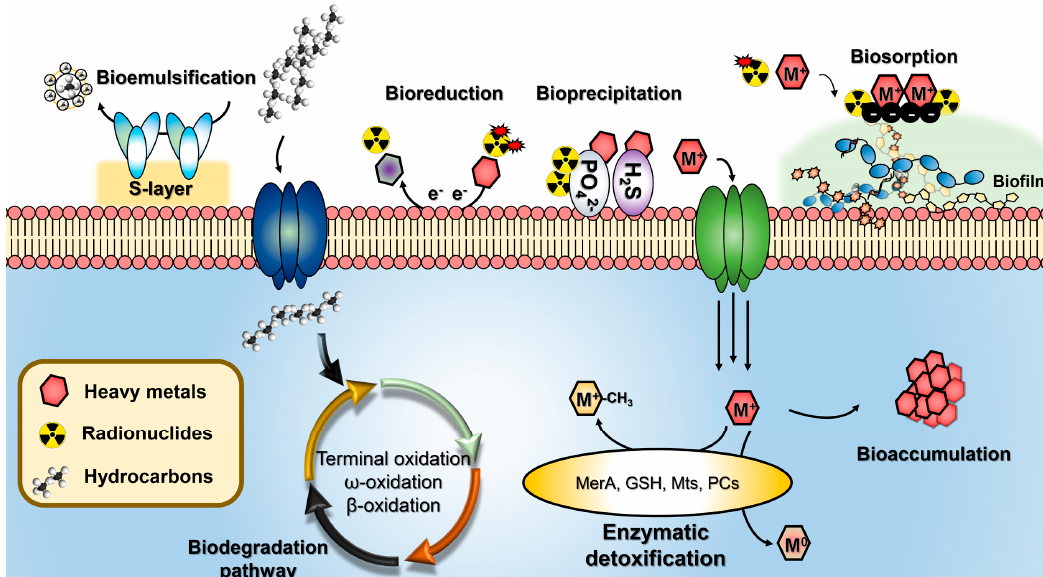
Figure 1. Current microbial bioremediation strategies for the removal of diverse toxic pollutants.